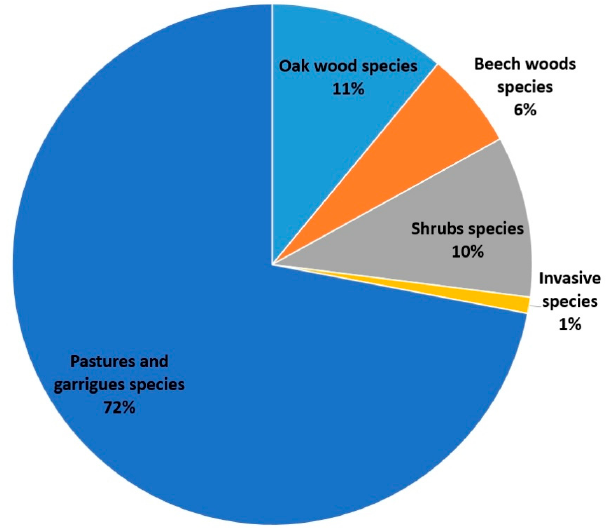
Figure 6. Phytosociological surveys carried out in the afforested area and analysis of the groups of species related to the phytosociological syntaxa.